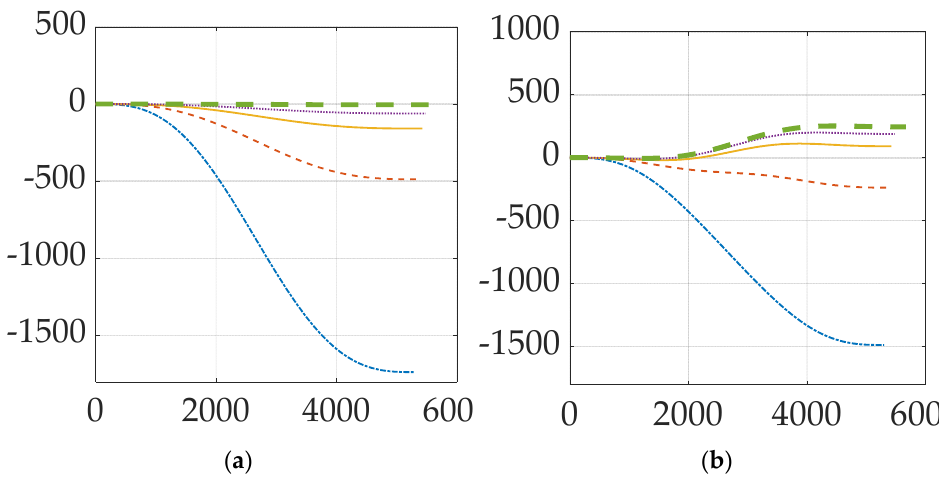
Figure 5. Altitude-change over one orbit with time in seconds on the abscissa and altitude change in meters on the ordinate. 200 km is blue, dash-dotted line; 250 km is red dashed line; 300 km is solid yellow line; 350 km is dotted purple line, and 500 km is green, thick dashed line: ( a ) Natural orbit decay from disturbances; ( b ) results with tether deployed.